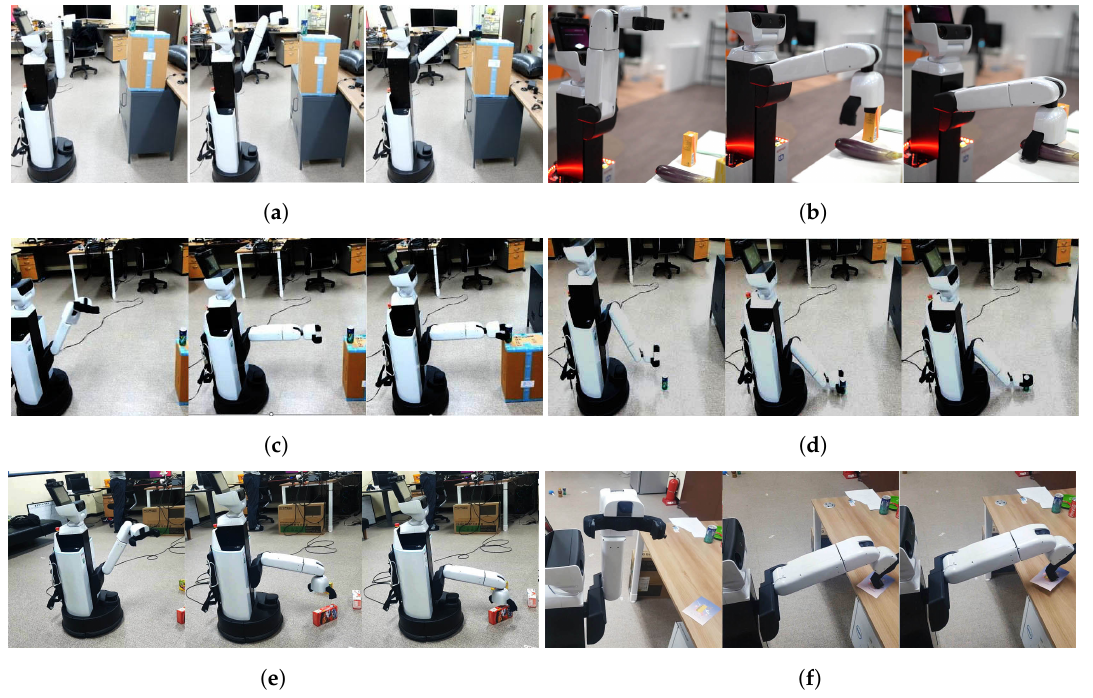
Figure 9. Various parameterized pickup motions for HSR. ( a ) High height, horizontal grasp, ( b ) High height, vertical grasp, ( c ) Medium height, straight arm grasp, ( d ) Low height, horizontal grasp, ( e ) Low height, vertical grasp and ( f ) Thin object, suction